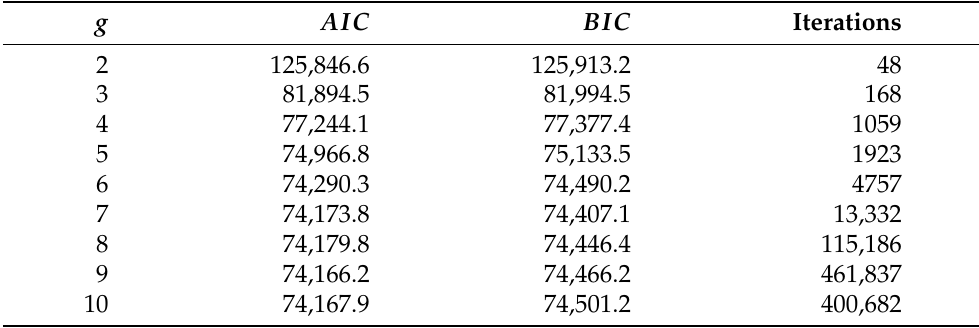
Table 1. Values of AIC and BIC for g from 2 to 10 for the estimation of the finite mixture model.